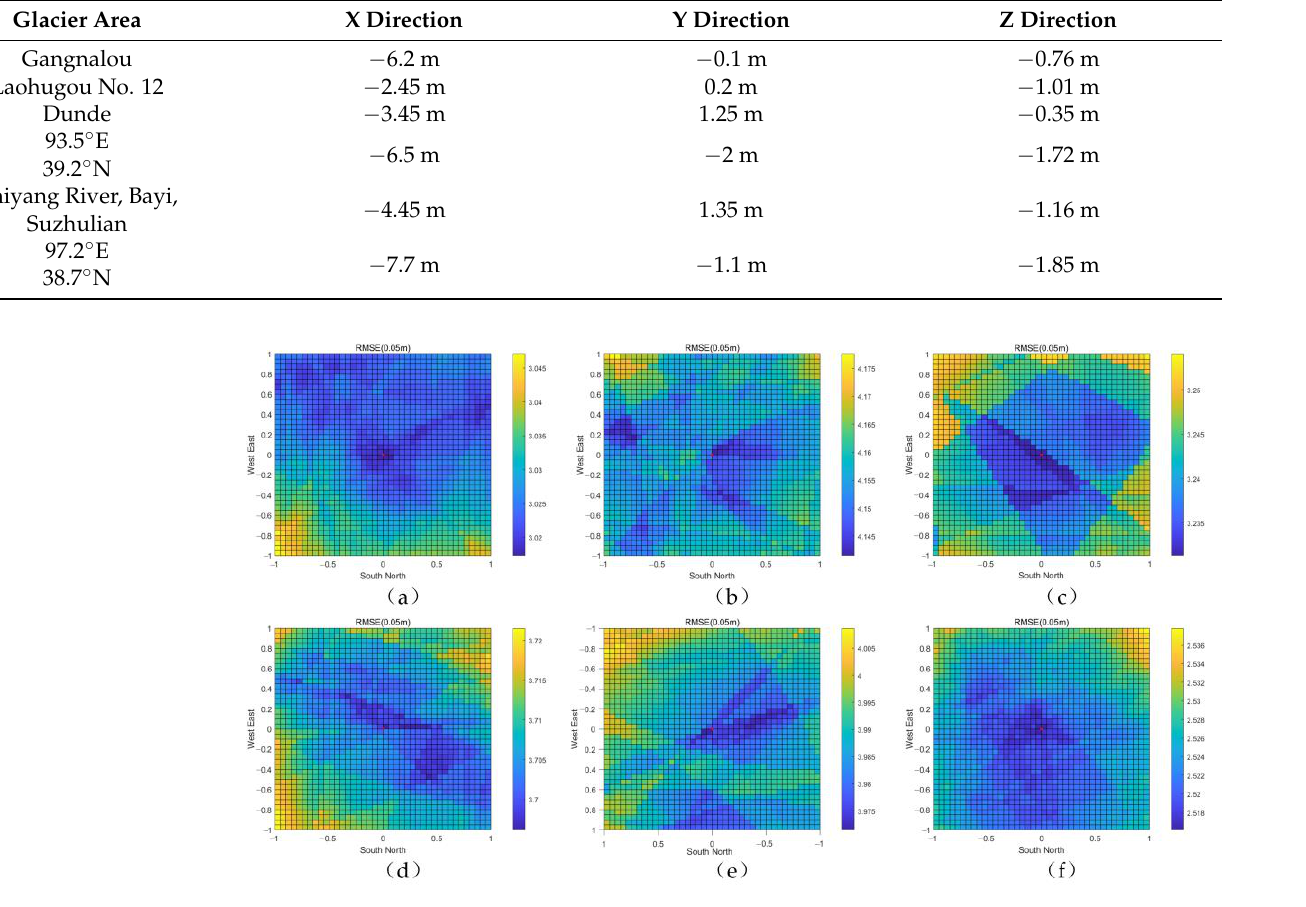
Figure 6. Pyramid registration result check. Using the same resolution as the third-level pyramid registration, the minimum point is marked in red, and the center point means that translation registration is no longer needed. ( a ) Gangnalou Glacier, ( b ) Laohugou No. 12 Glacier, ( c ) Dunde Ice Cap, ( d ) the 93.5°E 39.2°N Glaci-er, ( e ) Shiyang River, Bayi, and Suzhulian Glacier Group, and ( f ) the 97.2°E 38.7°N Glacier.